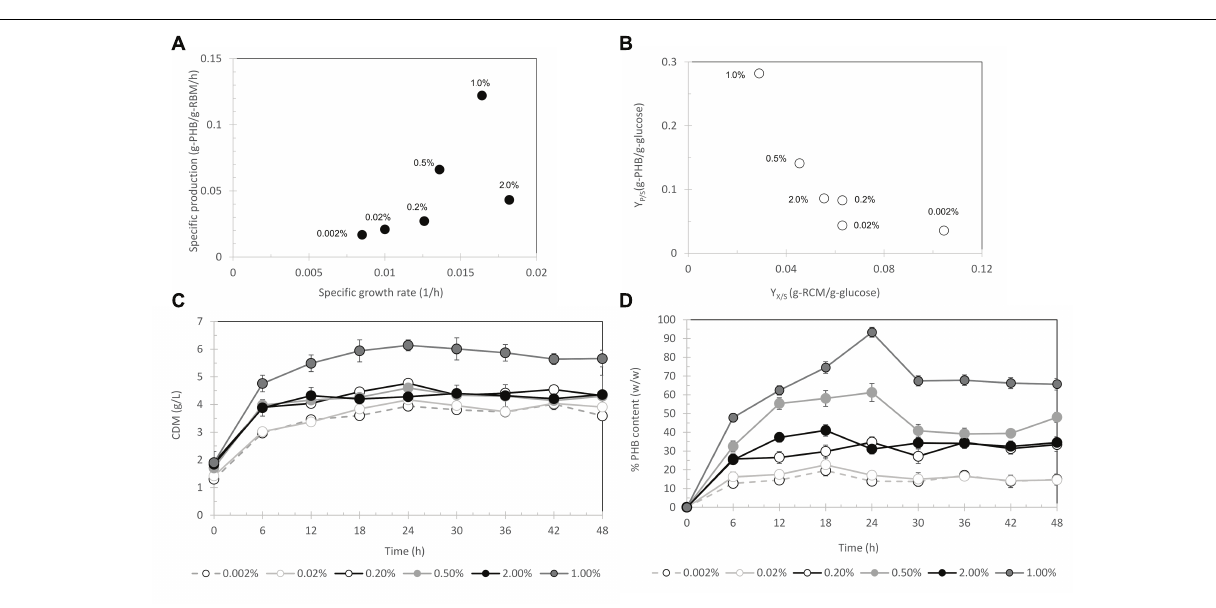
FIGURE 4 | Effect of L-arabinose concentrations of 0.002, 0.02, 0.2, 0.5, and 2% (w/v) on the relationship between the specific growth rate and specific production rate (A) and the relationship between Y X / S and Y P / S (B) time course of CDM (g/L) (C) and % PHB content (w/w) (D)